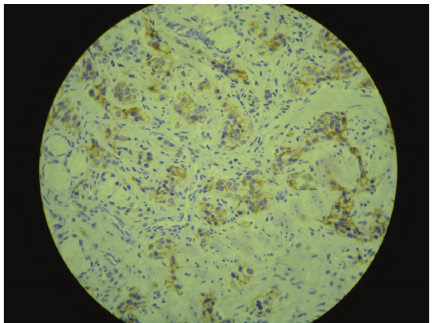
Figure 5: Immunohistochemistry exam positive for CD56.